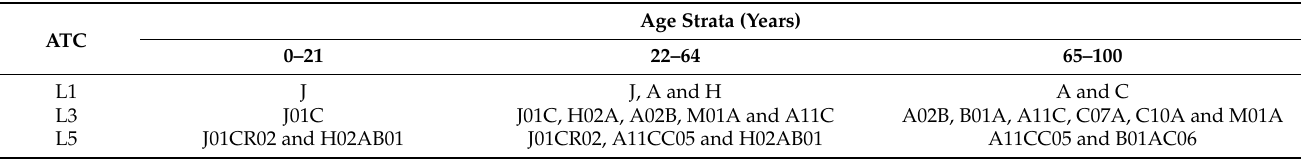
Table A1. Comparisons between DPNs (females vs. males). Representative ATCs endowed with the higher distance values.